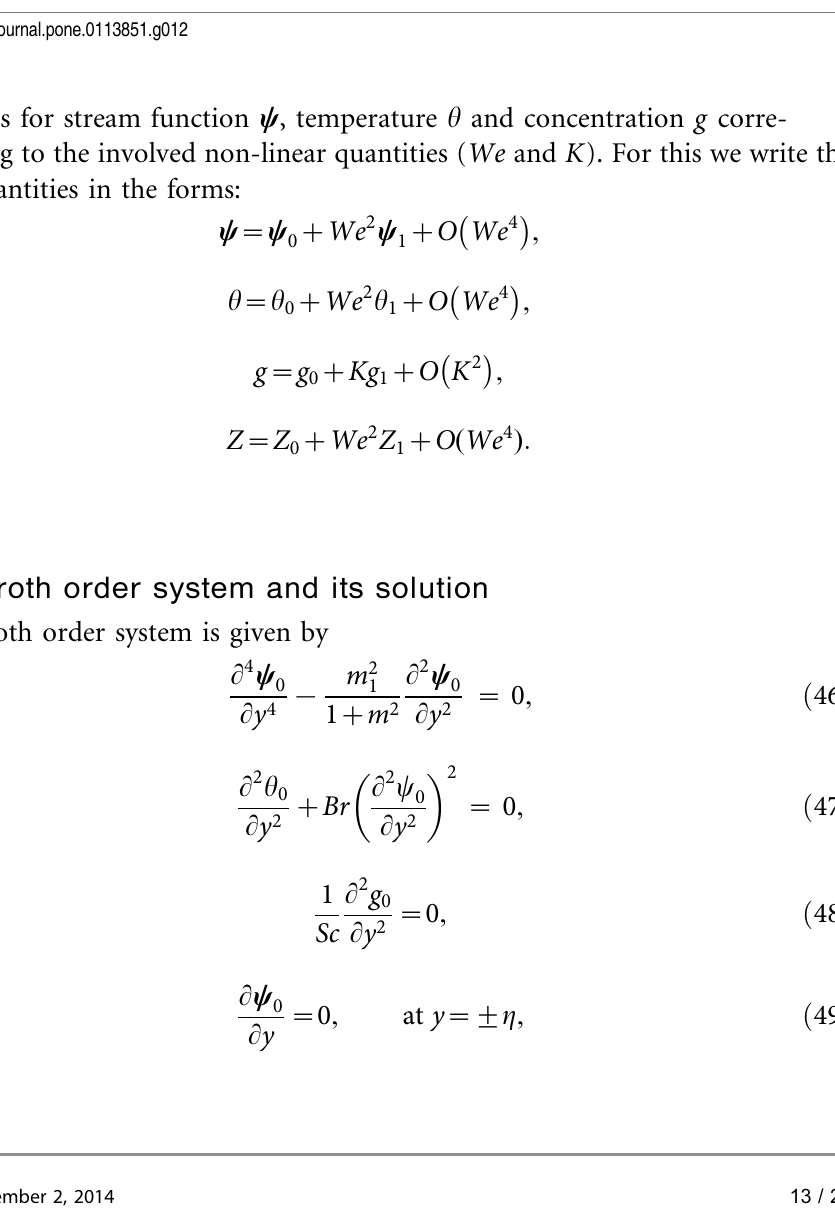
Figure 12. Plot of heat transfer coefficient Z for Biot number ª 2 with E ~ 0 : 1 , t ~ 0 : 01 , ª 1 ~ 4 , Br ~ 1 , E 1 ~ 0 : 4 ,